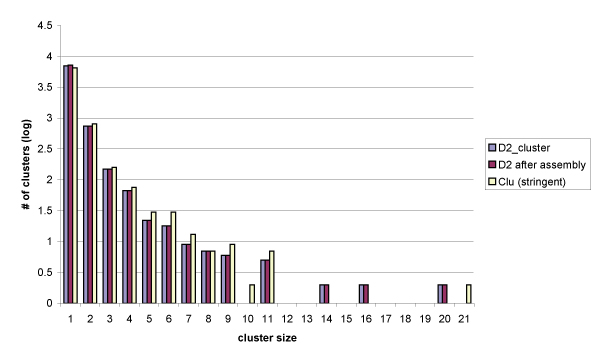
Comparison of cluster size distribution in first 10 000 human EST from eye tissue set.